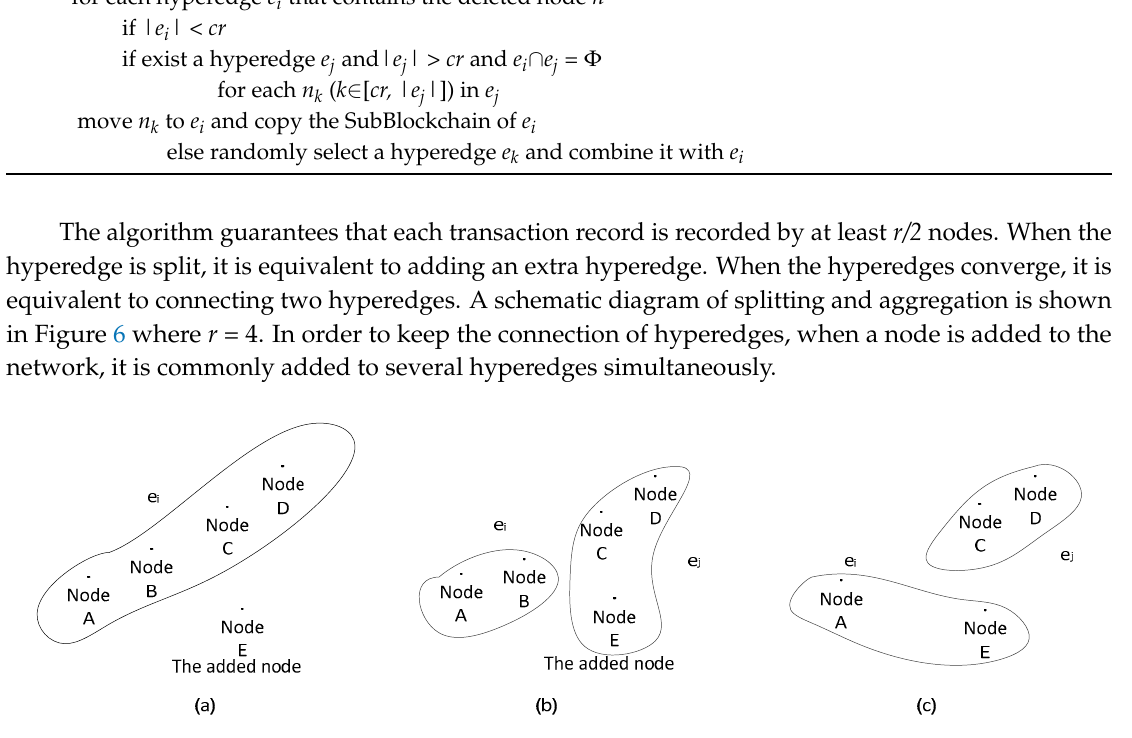
Figure 6. Adding a node and deleting a node from a network, ( a ) before Node E is added, ( b ) after Node E is added, ( c ) after Node B is deleted.